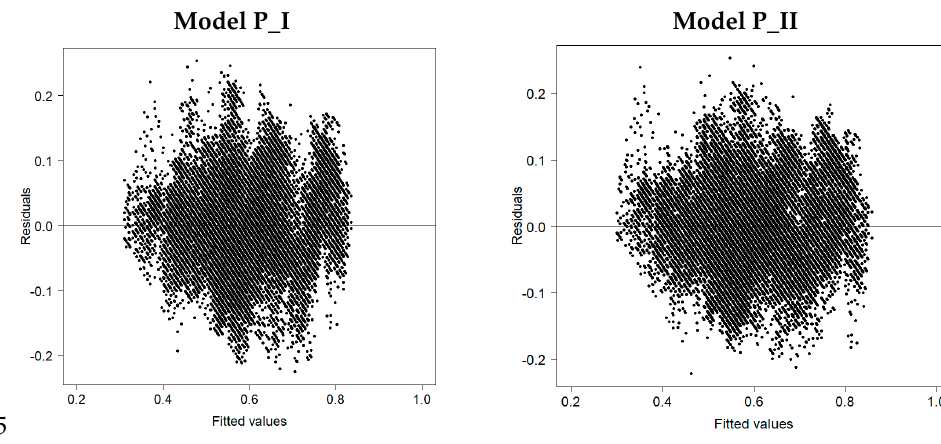
Figure 7. Residuals versus fitted values for Models P.